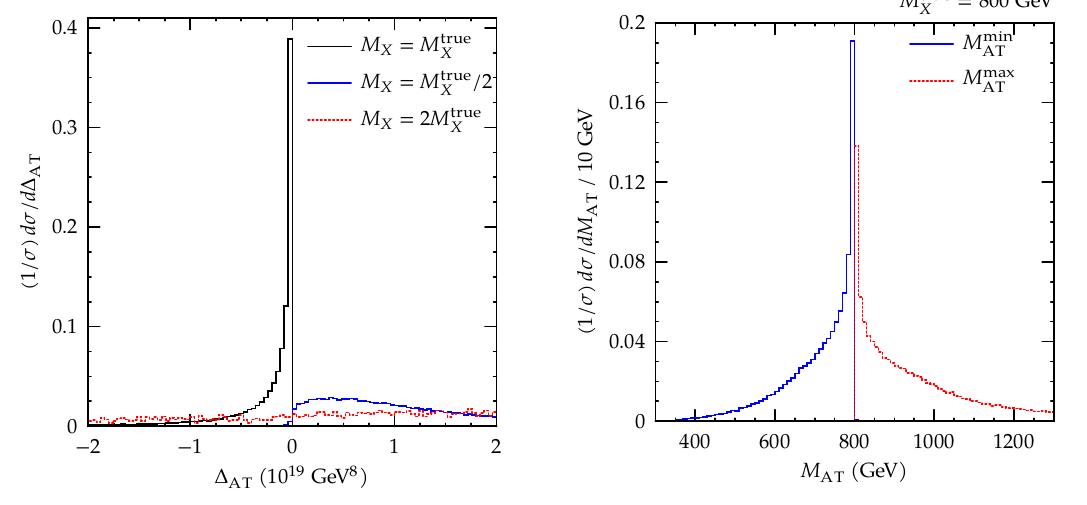
Figure 2 . The (cid:1) AT (left) and M AT (right) distributions for pure phase space. The resonance X is produced at rest, Q = 0 and Q L = 0. For (cid:1) AT , the resonance mass M X is the input parameter. T resonance was produced at rest. For M X = M true , we can see a remarkably sharp peak at X (cid:1) AT = 0, which con(cid:12)rms that the singular feature is maximized at the true mass